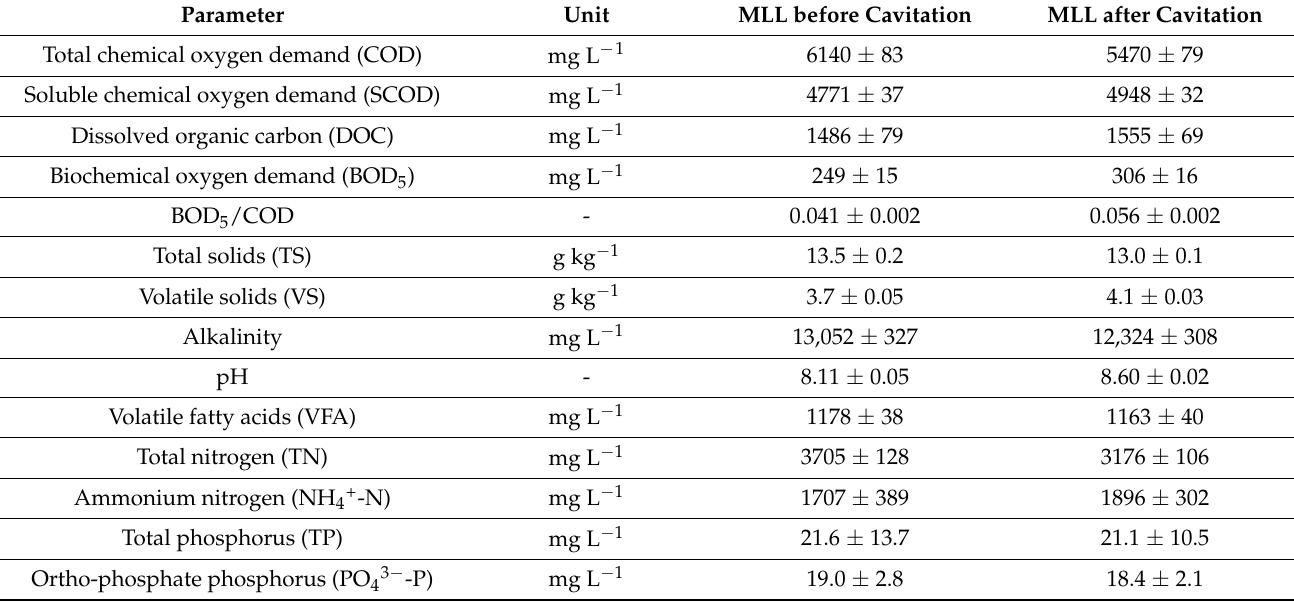
Table 1. Composition of mature landfill leachate (MLL) before and after cavitation (average value ± standard